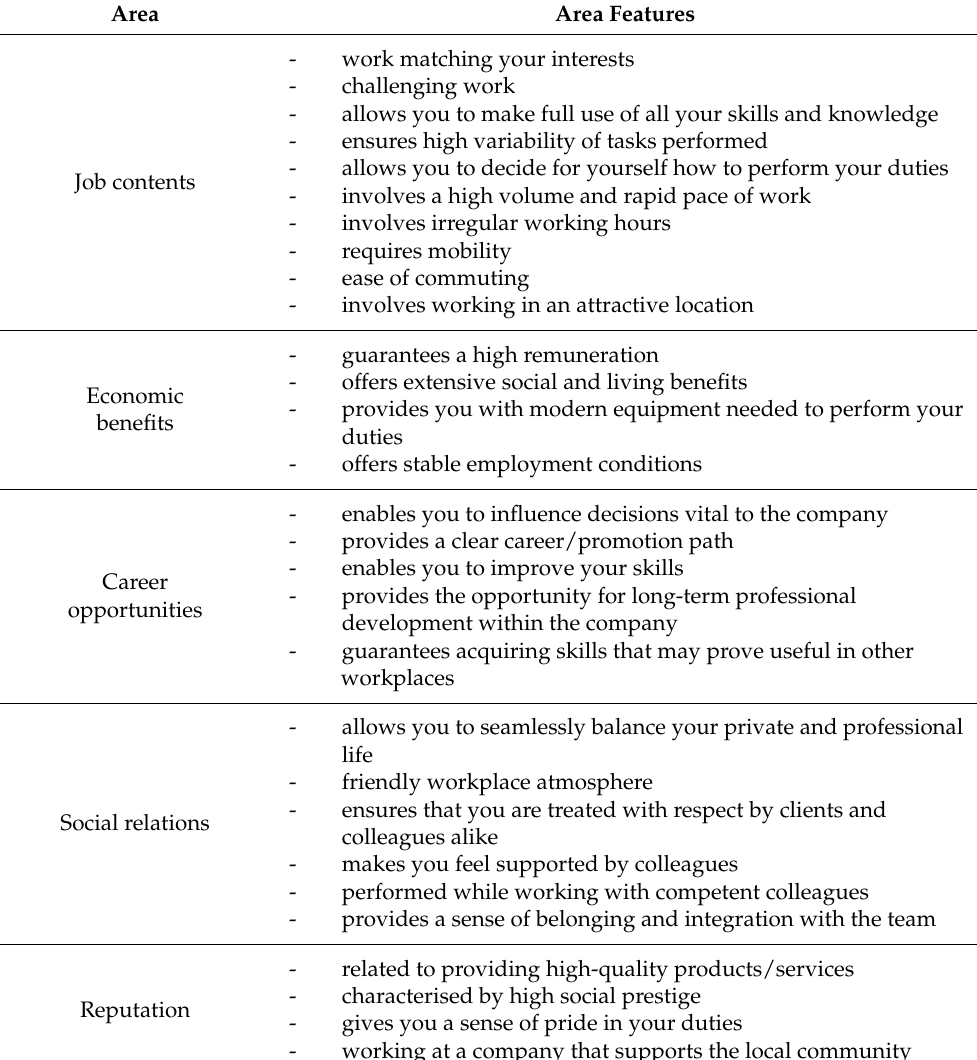
Table 1. Areas of research interest and associated